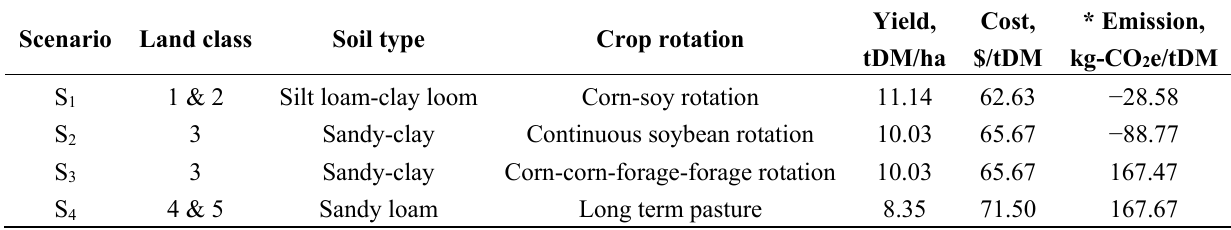
Table 1. Scenarios of this